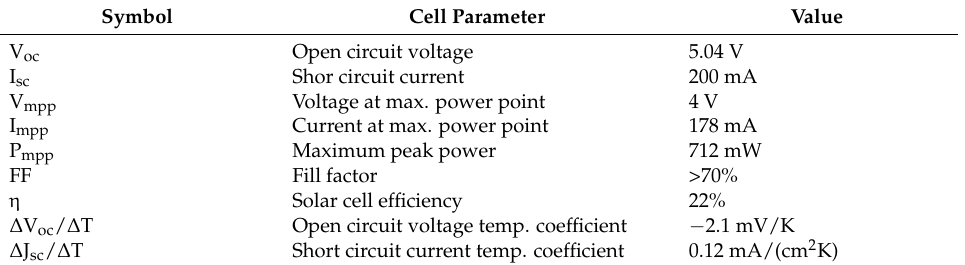
Table 1. SLMD481H08 solar module electrical characteristics [24].